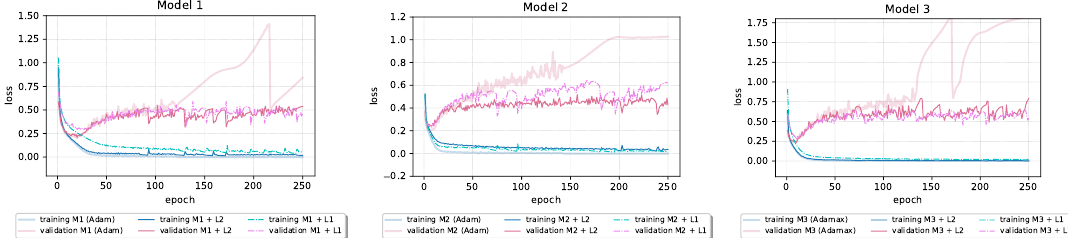
Figure 8. Loss learning curves of models that incorporate L 2 and L 1 weight decay in baseline models trained on Fashion-MNIST dataset.